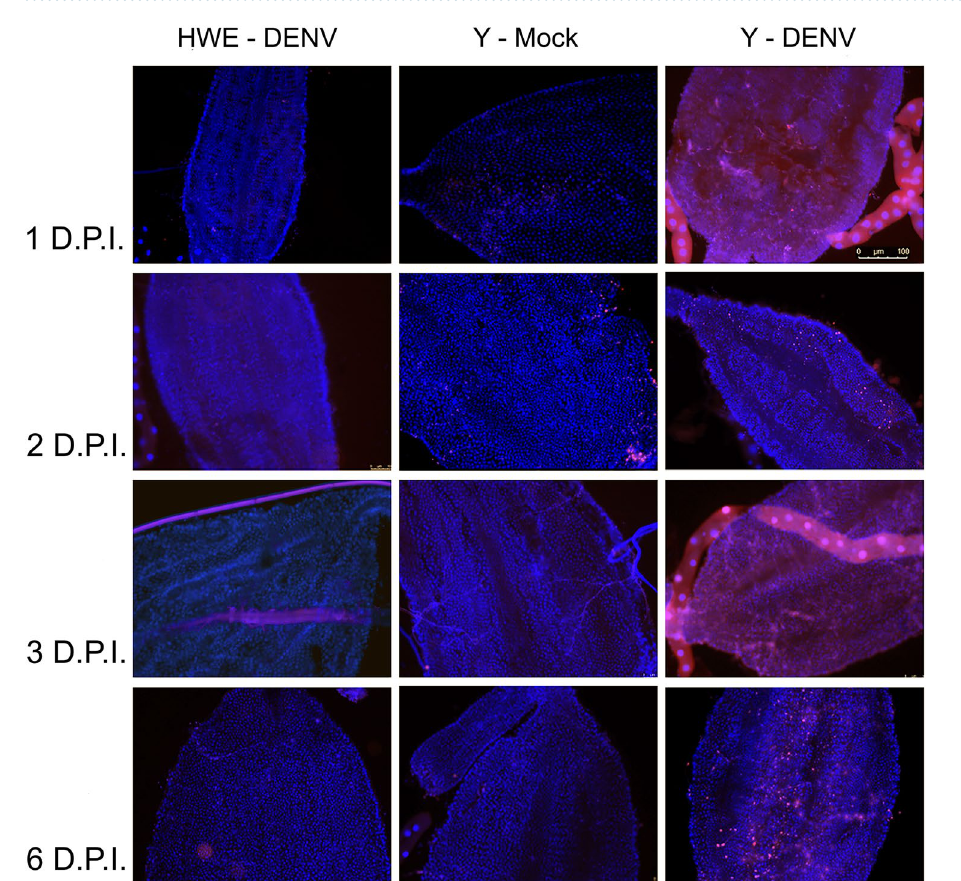
Figure 5. TUNEL staining of midguts from HWE (Higgs) and line Y females at 1, 2, 3, and 6 DPI following infection of mosquitoes with DENV-2 via intrathoracic injection. Counterstaining was performed using Hoechst 33342. Y-MOCK represents the Y line injected with cell culture supernatant containing no